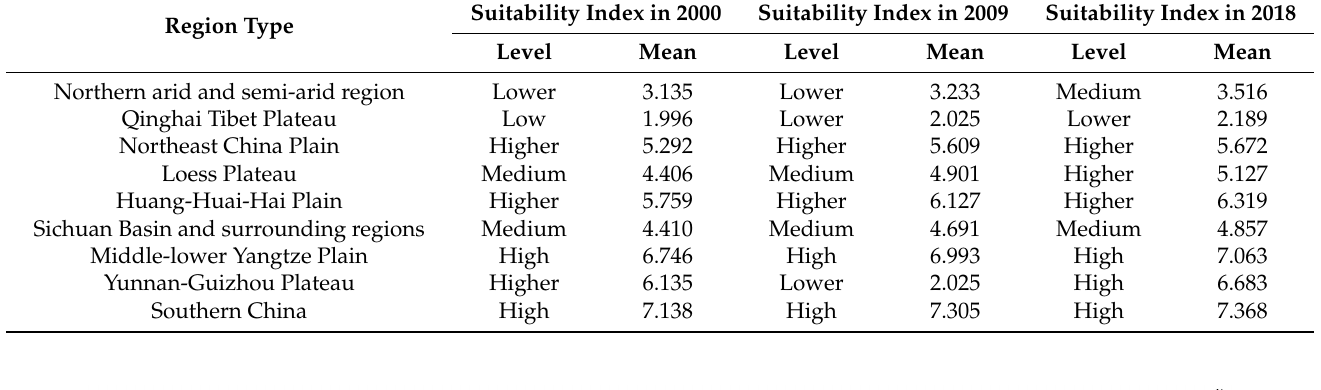
Table 3. Mathematical characteristics of agricultural production space suitability in nine agricul- tural areas.